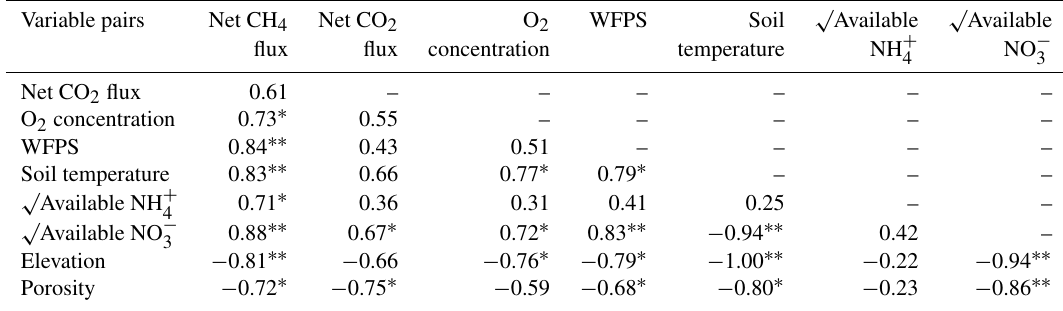
Table 3. Pearson’s correlation coefficient matrix for dataset plot means of measured variables across forest types. Variable pairs